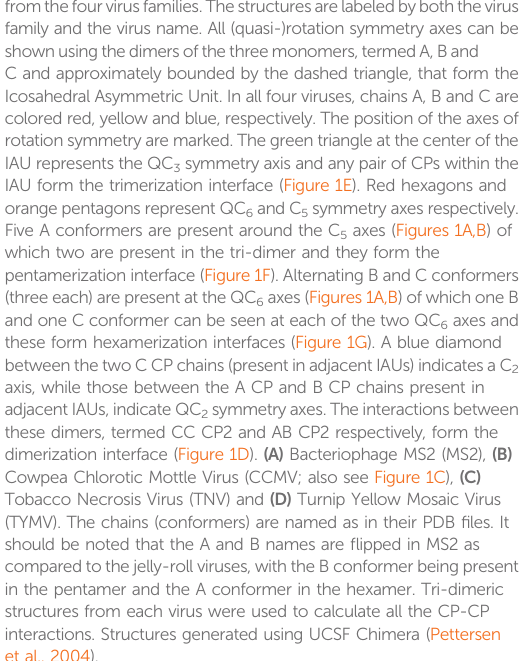
Tymoviridae families have positive-sense single-stranded RNA genomes enclosed in T = 3 icosahedral capsids (King et al., 2012).